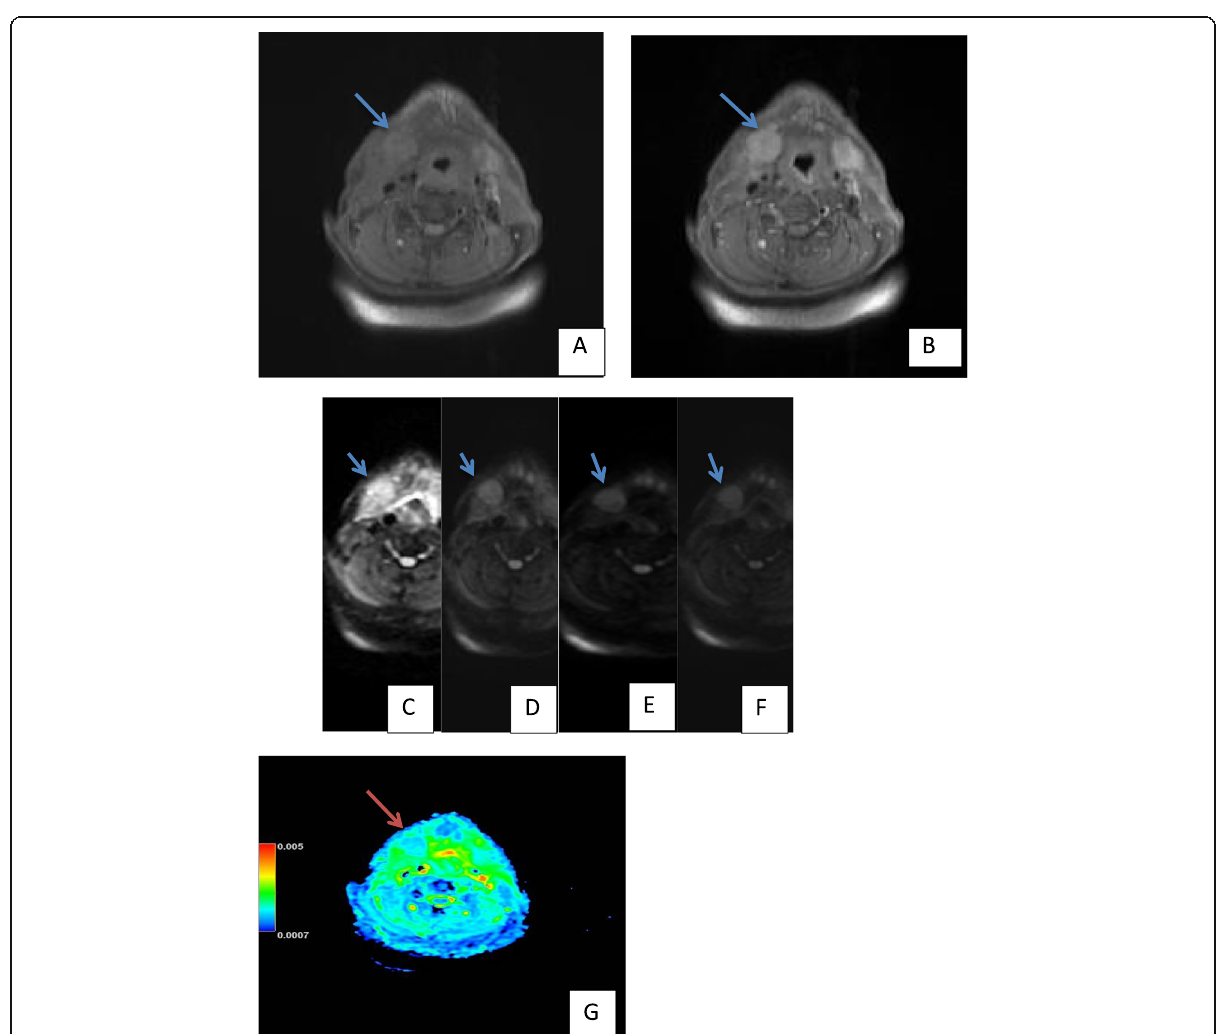
Fig. 4 Thirty-three-year-old female patient with right submandibular lymphadenitis. a Axial T1. b Axial T1 + C. c – f Axial diffusion-weighted imaging with b values: 50, 400, 800, and 1000 respectively. g ADC map axial images showed mild enlarged right submandibular gland with no focal lesion; it displays homogeneous isointense signal intensity in T1, homogenous enhancement after IV contrast. The gland elicits high signal intensity in DWI, in both low and high b values, with corresponding intermediate signal intensity in ADC map (partially restricted diffusion), ADC value = 1.67 × 10 − 3 s/mm 2